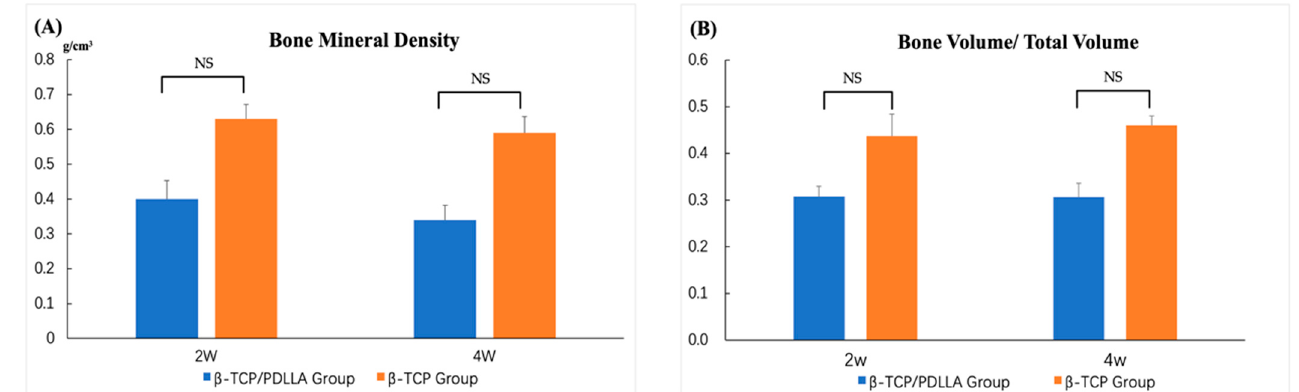
Figure 4. Micro-CT analysis of the ( A ) bone mineral density (BMD) and ( B ) bone volume/total volume (BV/TV) of the β -TCP/PDLLA and β -TCP groups. Mann–Whitney U Test; NS, not significant. Error bars indicate standard deviation.